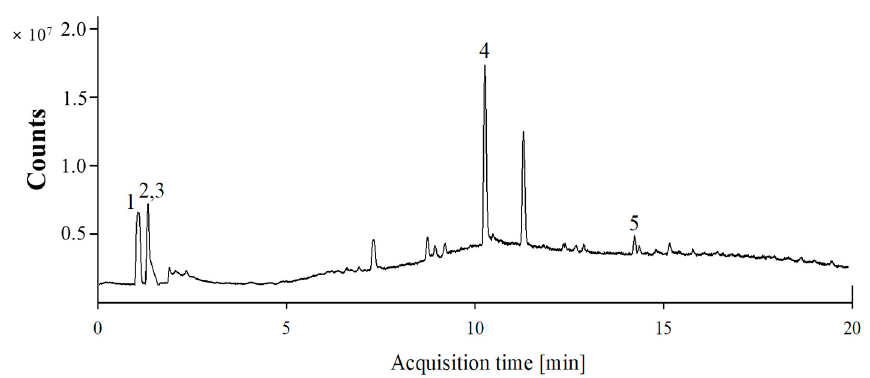
Figure 1. Representative LC-MS chromatogram of S. horneri extract. 1. Fucoxanthin, 2. Salicortin, 3. Feruloylquinic acid, 4. Loliolide, and 5. Vitexin.